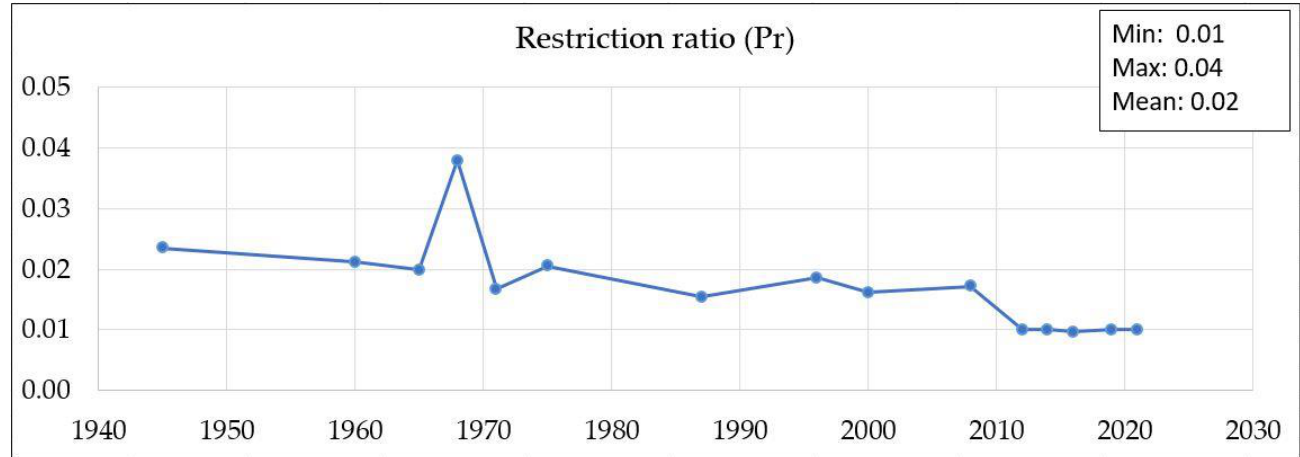
Figure 5. Lagoon restriction ratio index fluctuations during the study period.